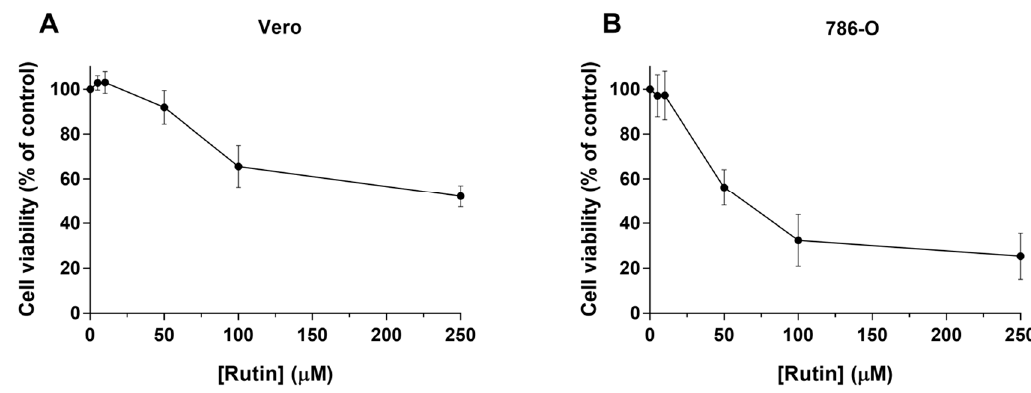
Figure 1. Cytotoxic e ff ects of rutin (0–250 µ M; 48 h) in Vero ( A ) and 786-O ( B ) cells. The viability of rutin-exposed cells was evaluated by MTT assay. Values represent mean ± SD ( n = 6–7) and are expressed as percentages of the non-treated control cells.